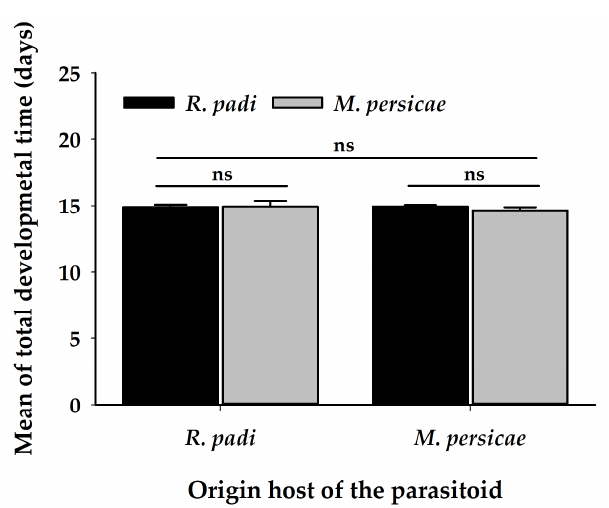
Figure 6. ( A ) Parasitism rate (mean ± SE) (i.e., proportion of aphid mummies formed) and ( B ) Emergence rate (mean ± SE) of adult progeny of A. platensis from two origins parasitizing the same aphid host. Asterisks indicate significant differences: ‘***’ p < 0.001, ‘**’ p < 0.01 ‘*’ p < 0.05, ‘ns’ non- significant p > 0.05. Black and grey bars show the chosen/tested host.